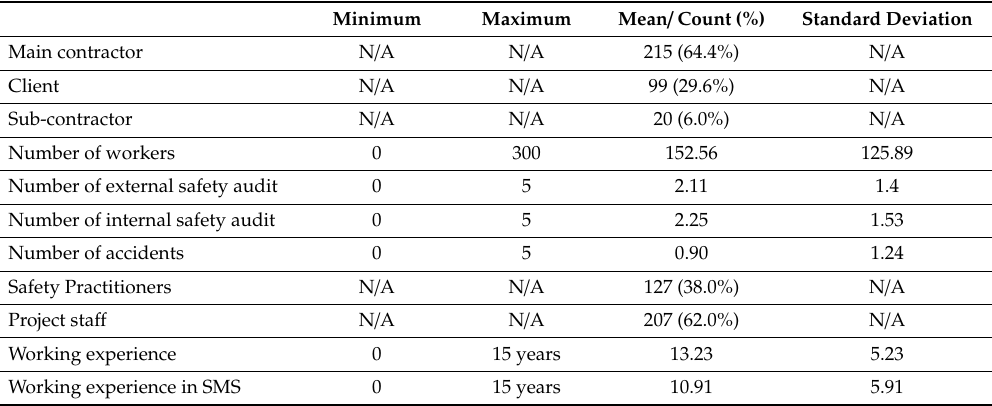
Table 3. Descriptive Statistics of the Participated